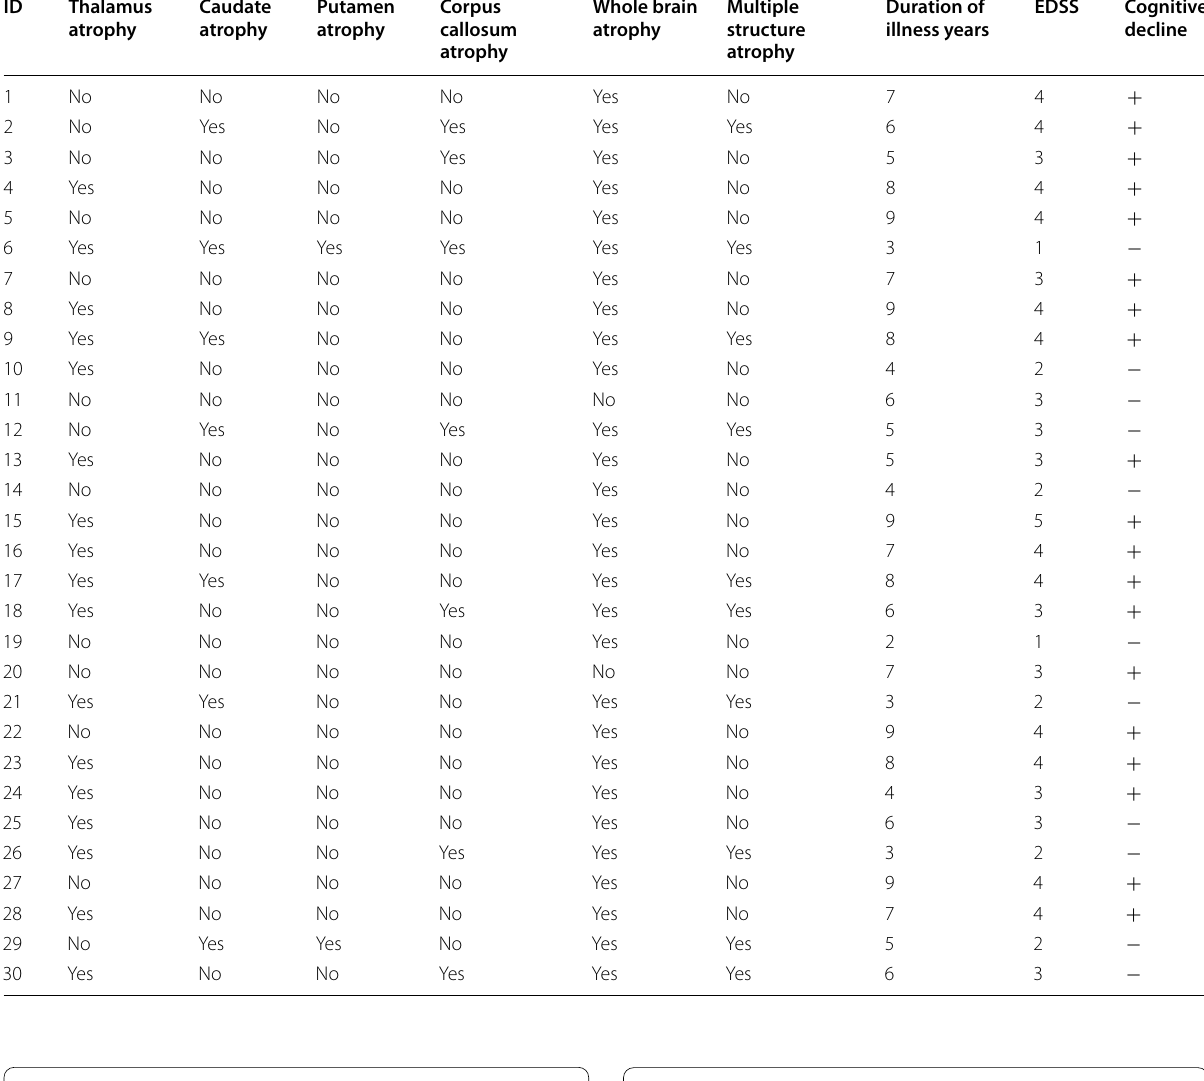
Table 7 Display results of each patient